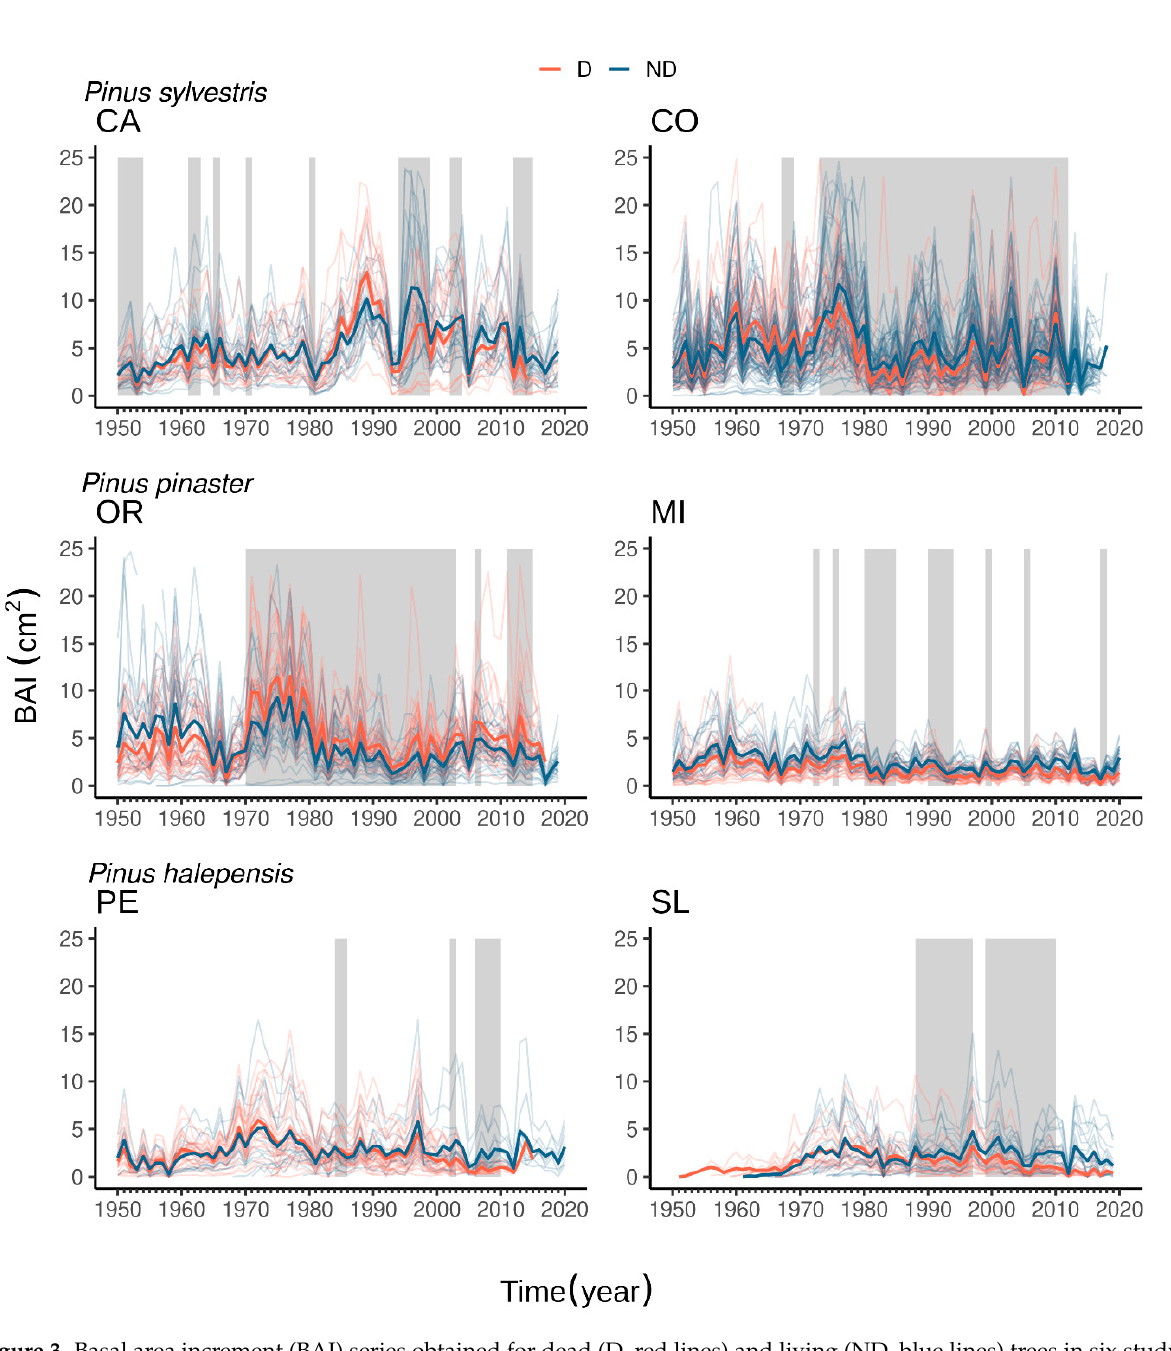
Figure 3. Basal area increment (BAI) series obtained for dead (D, red lines) and living (ND, blue lines) trees in six study sites (Table 3). Solid and thicker lines show the mean BAI data of each group. The grey boxes show periods with significant (p < 0.05) differences in BAI between D and ND trees (see Table S2).